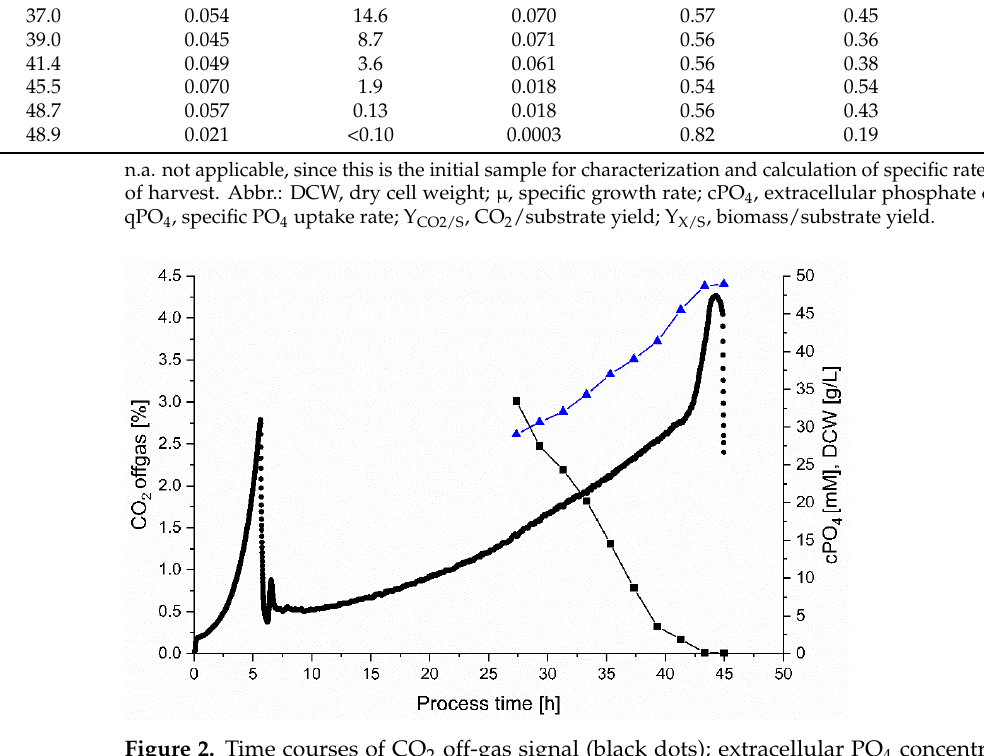
Figure 2. Time courses of CO 2 off-gas signal (black dots); extracellular PO 4 concentration (cPO 4 ; black squares) and E. coli dry cell weight (DCW; blue triangles) during fed-batch cultivation until PO 4 starvation (indicated by a stagnation of the CO 2 off-gas signal at around 43 h). The sudden drop of the CO 2 off-gas signal at the end of cultivation (45 h) resulted from stopping the feed pump (C-source limitation) prior to cultivation